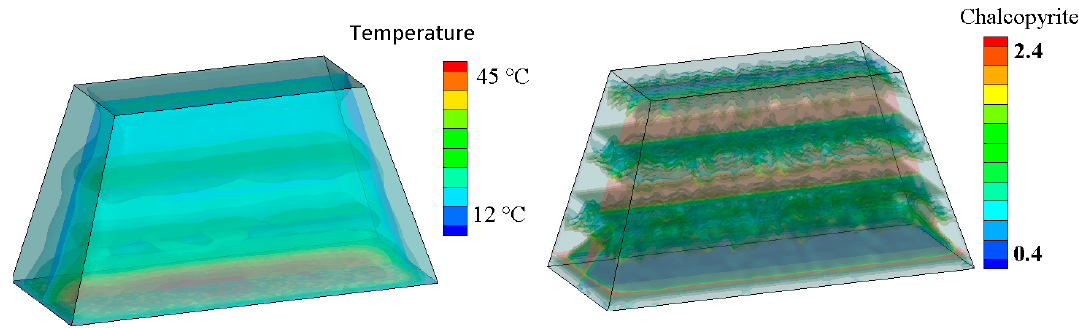
Figure 8. Contour plots of ore after 17 months of heap leach cycle.